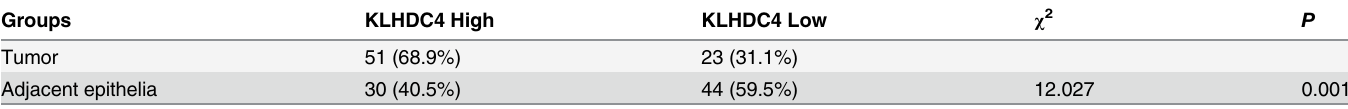
Table 1. KLHDC4 expression correlation in NPC and adjacent nasopharyngeal epithelia.